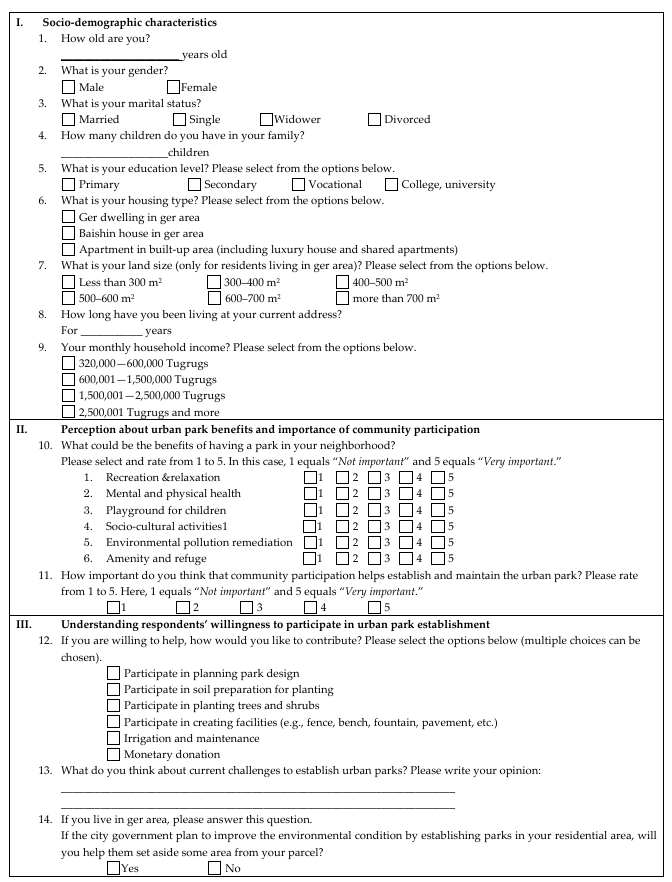
Table A1. Questionnaire Structure. Land 2021 , 10 , x FOR PEER